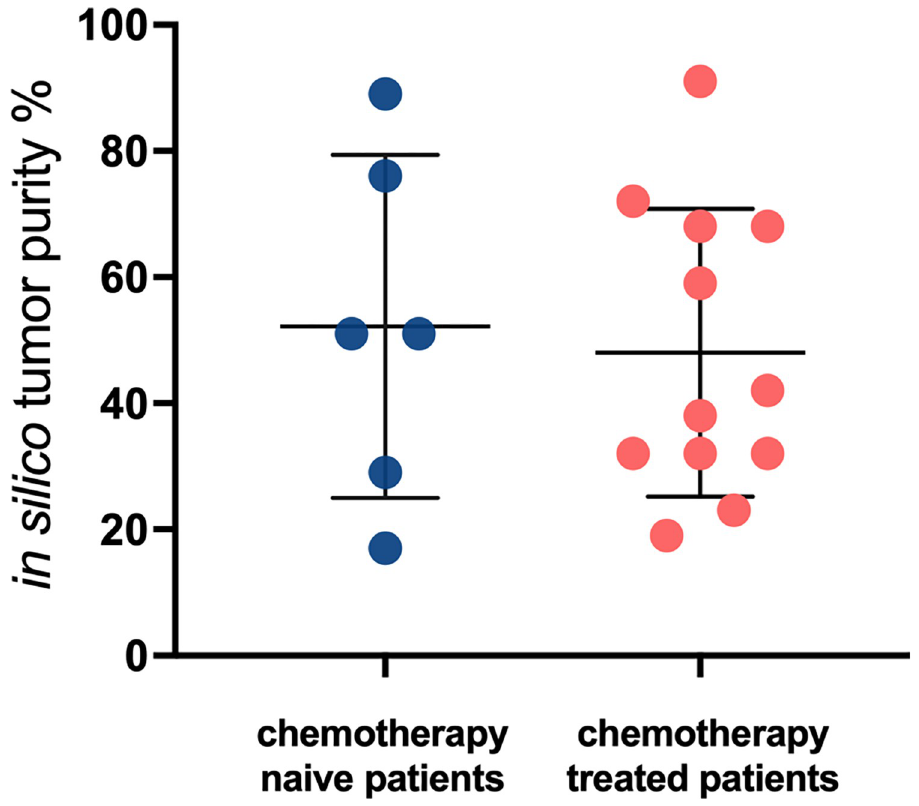
Fig 6. PureCN tumor purity estimates with mean and standard deviation for all 18 patients grouped by their chemotherapy status prior to